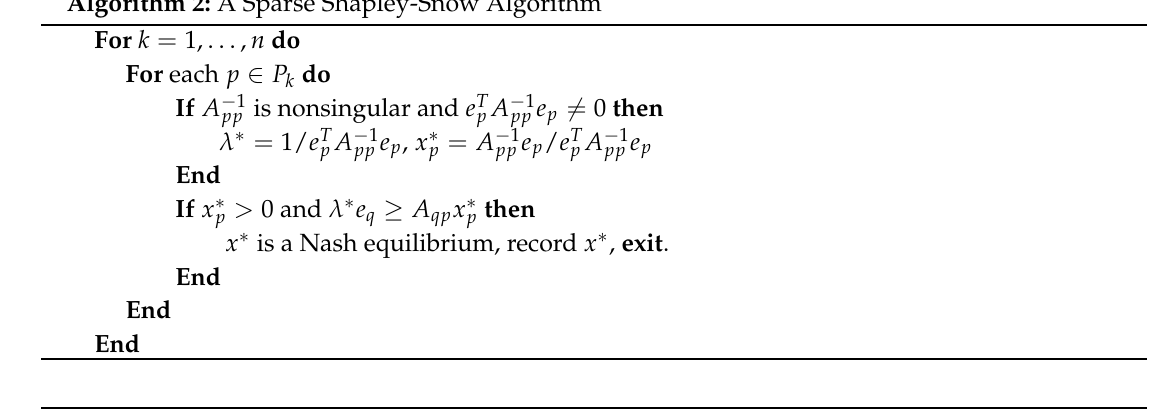
Algorithm 3: A Dense Shapley-Snow Algorithm For k = n , . . . , 1